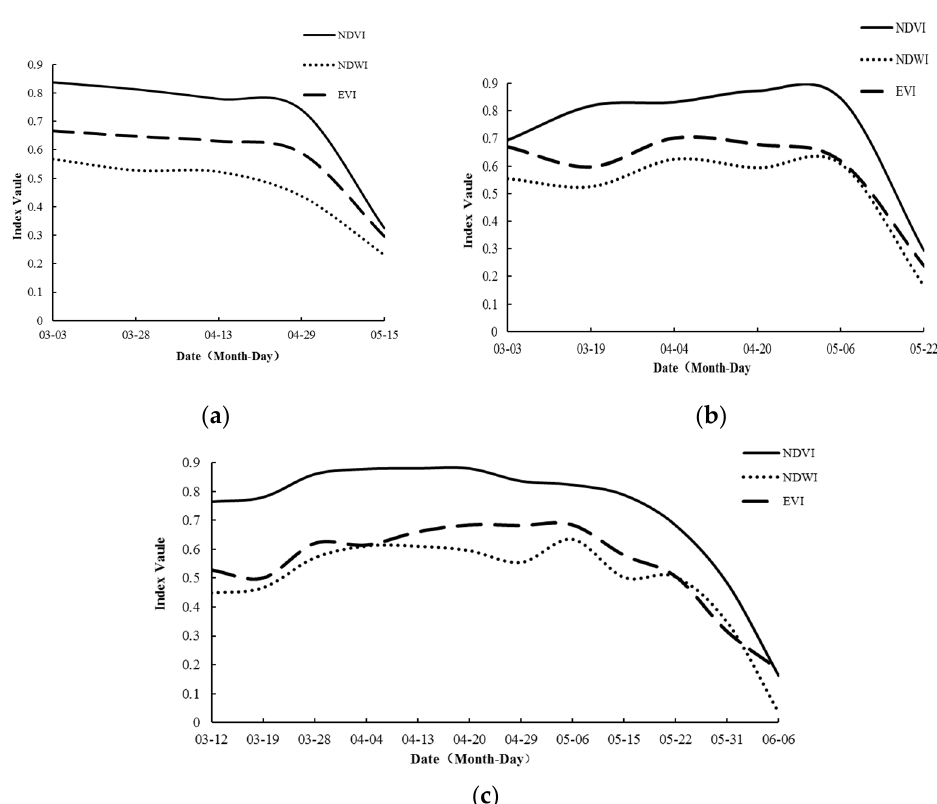
Figure 3. Chart of variation trend of NDVI , NDWI and EVI of Zhumadian ( a ), Zhengzhou ( b ) and Anyang ( c ) based on remote sensing data.